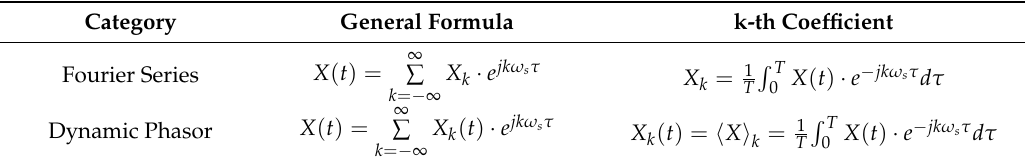
Table 2. General formula of Fourier series and dynamic